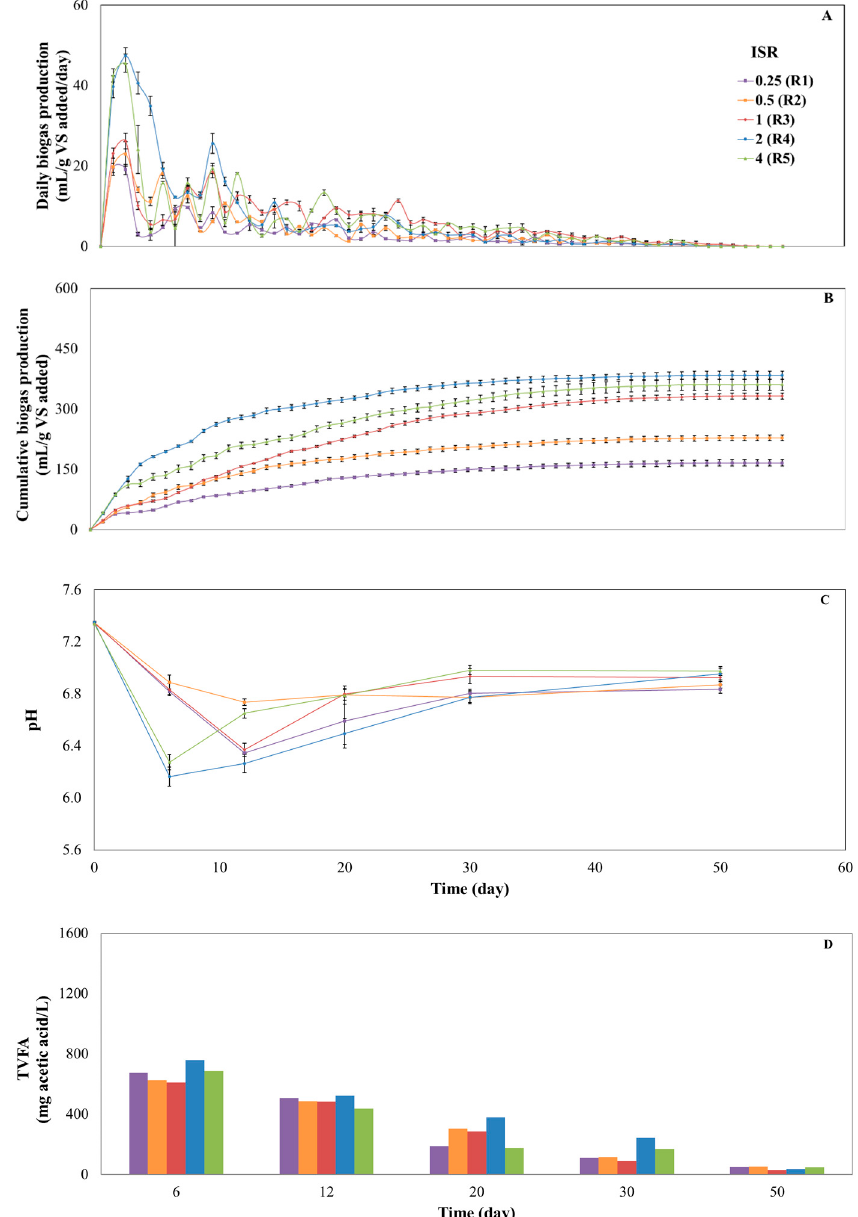
Figure 1. E ff ect of the inoculum-to-substrate ratio on the daily biogas production ( A ), the cumulative biogas production ( B ), the pH ( C ), and total volatile fatty acids (TVFA) accumulation ( D ), from the anaerobic digestion of potato peels.